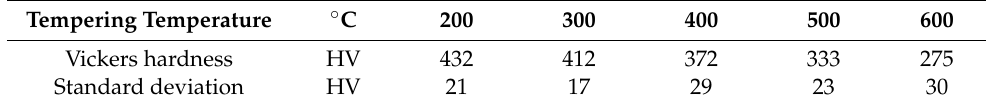
Table 3. Average Vickers hardnesses for tested tempering temperatures.